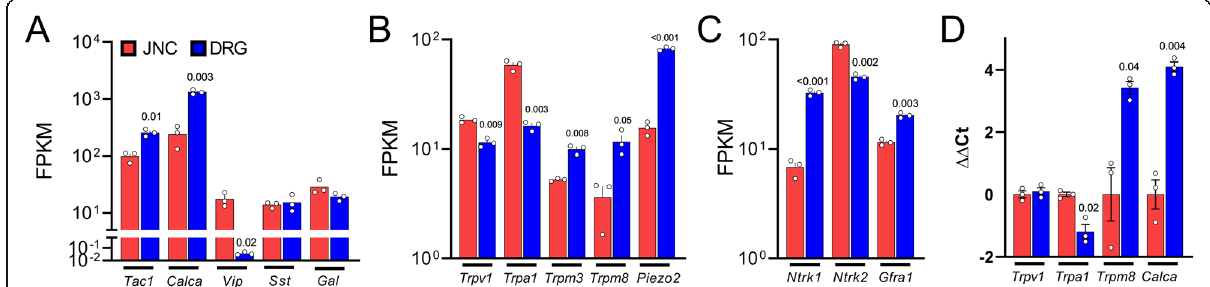
Fig. 1 Lumbar and vagal neurons transcriptomes are different. ( A - C ) The whole jugular nodose ganglia complex (JNC; n=3; red) and dorsal root ganglia (DRG; n=3; blue) mouse transcriptomes were profiled using RNA sequencing (RNA-seq; Illumina HiSeq 2500) by Kaelberer et al ., 2020. In- silico analysis of the neuron's transcriptome revealed that naïve mouse JNC nociceptor neurons express different neuropeptides ( A ), ion channel receptors ( B ), and growth factor receptors ( C ) than the one found in DRG. JNC neurons are enriched for Vip , Trpv1 , Trpa1 , and Ntrk2 , while DRG neurons show higher higher levels of Calca , Tac1 , Trpm8 , Trpm3 , Piezo2 , Gfra1 and Ntrk1 . ( D ) Gene expression was also assessed by RT-qPCR after 24 hours of culture ( D ). ΔΔ Ct was calculated in comparison to JNC. Trpm8 and Calca were enriched in DRG neurons, while Trpa1 was enriched in JNC neurons ( D ). Expression across datasets is shown as Fragments Per Kilobase of transcript per Million reads mapped (FPKM) ( A - C ) or ΔΔ Ct with JNC as the control condition ( D ) . Data are shown as means ± S . E . M . N=3/groups . P - values are shown in the figure and determined by unpaired multiple Student t -test with Hidom-Sidak corrections ( A - D ) . Experimental details were defined in Kaelberer et al., 2020 ( A - C